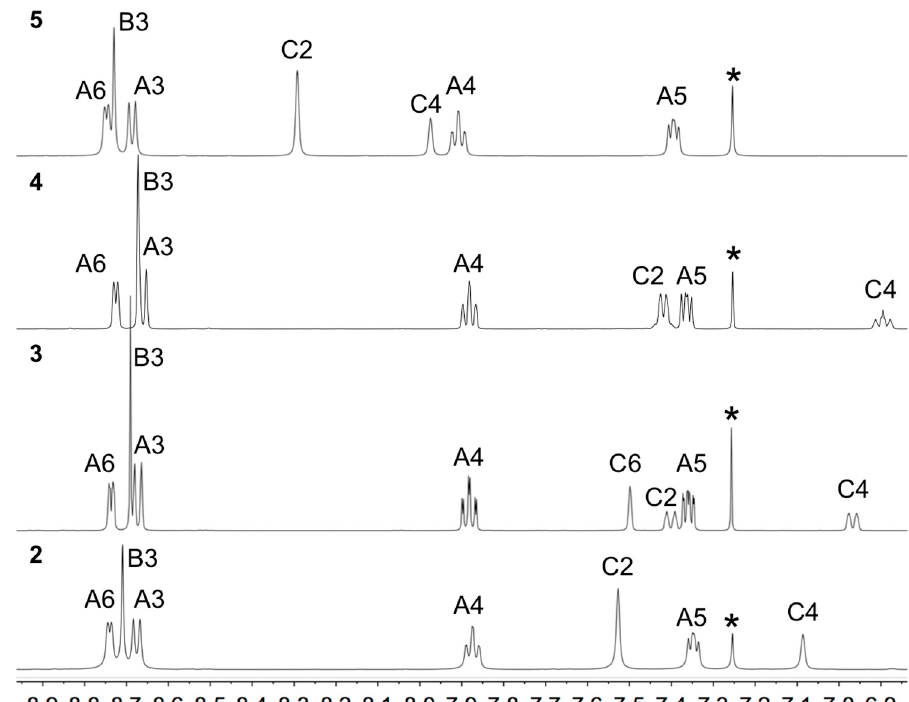
Figure 1. Aromatic regions of the 1 H NMR spectra (500 MHz, CDCl 3 ) of compounds 2–5 with atom labeling as shown in Scheme 1. * = residual CHCl 3 . Chemical shifts in δ /ppm.